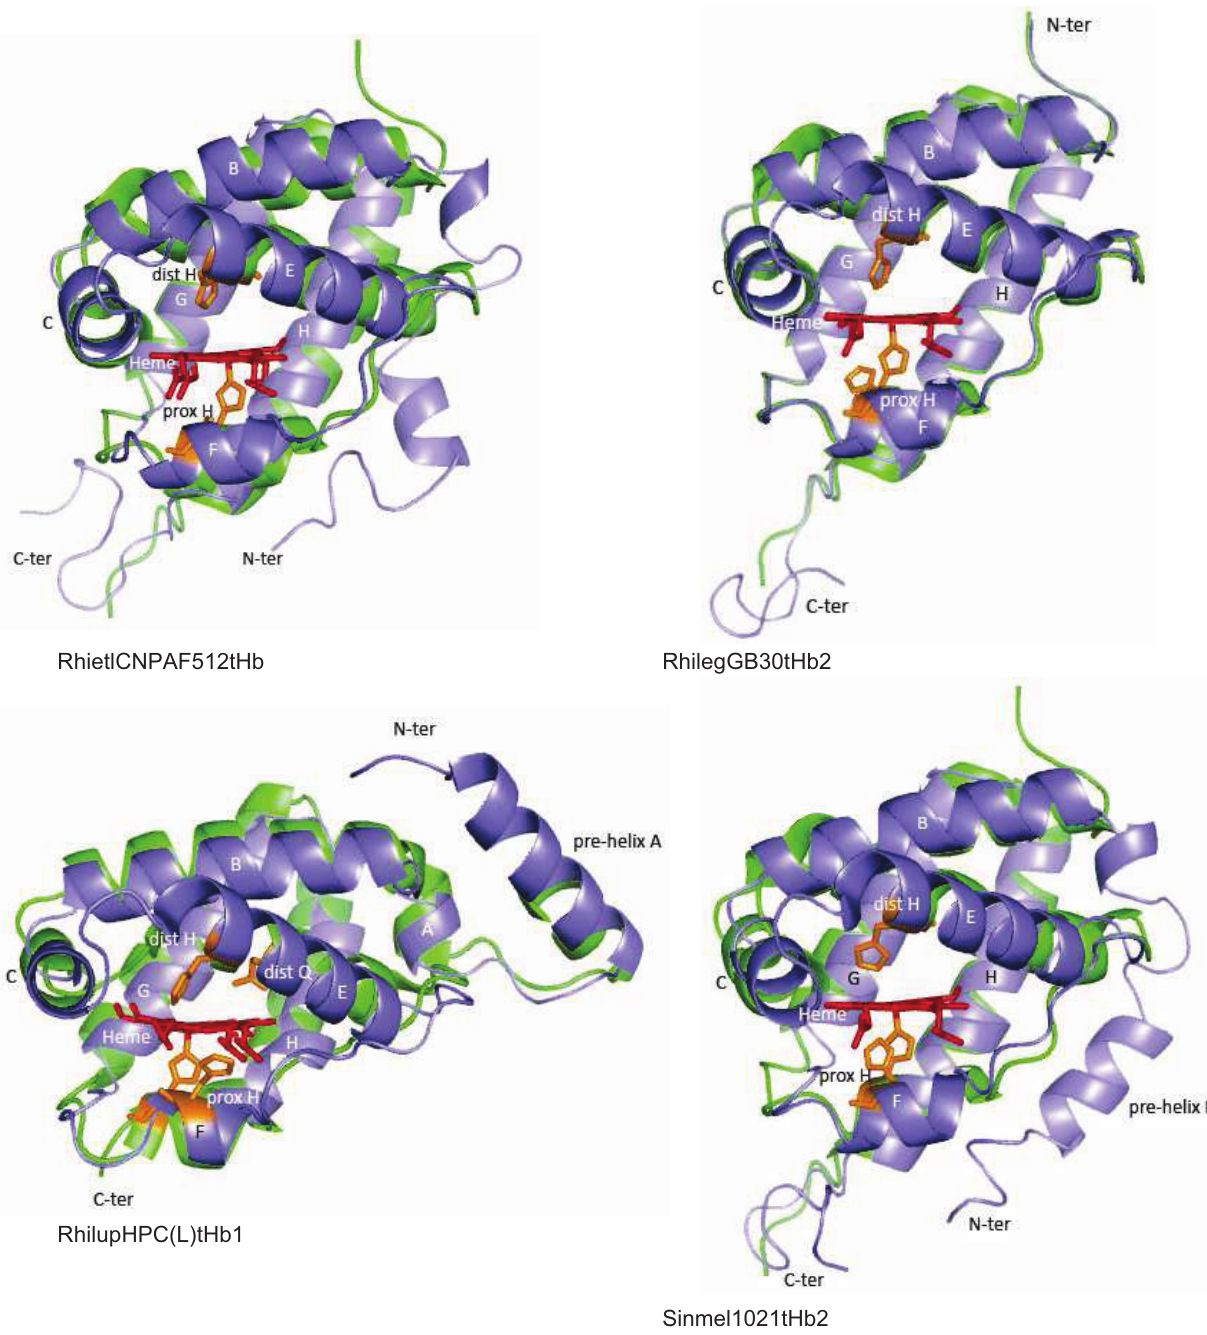
Figure 8. Predicted structure of selected rhizobial tHbs class 3 (blue) overlapped to structural homologues (green). Structural homologues are indicated in Dataset 3. Distal and proximal amino acids to the heme Fe are shown in brown; only potential distal E11 is shown in the tHbs structure. Heme is shown in red. Helices are indicated with letters A to H. All structures are displayed in the same